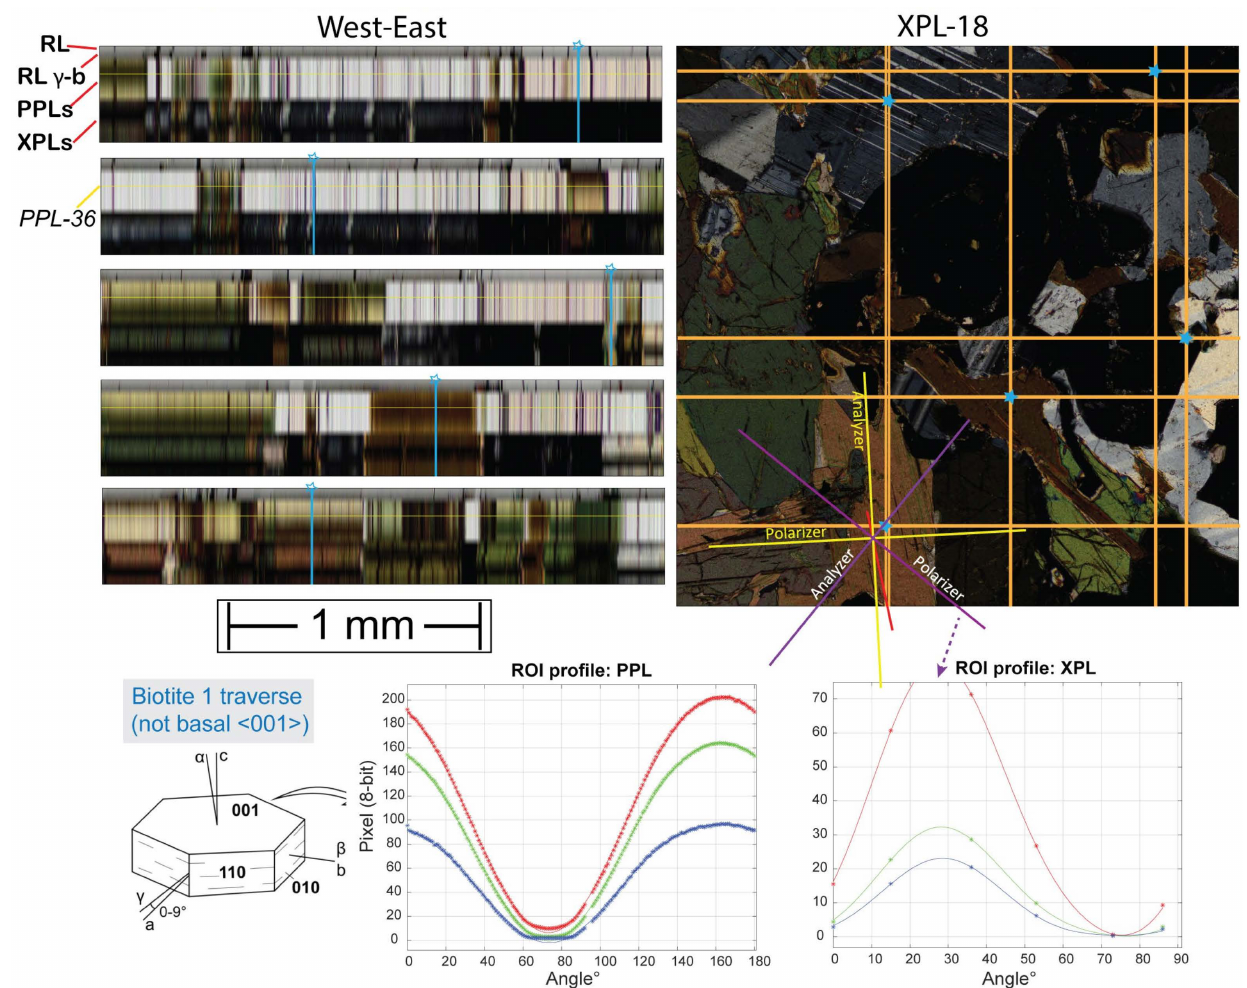
Figure 10. Orthogonal views of Figure 9 stack (pyramidal level = 0) of the hornblende granulite KB-67. The PPL-36 ( top-left ) and XPL-18 ( middle-right ) positions illustrate the mineralogy. Five pixels of distinct mineralogy (biotite 1 and 2, plagioclase, garnet, and chlorite) are marked (blue stars) for each modality (RL, PPL, XPL) and orientation. Colour gradients within the orthogonal traverses are arranged left–right (vertical) and top–bottom (horizontal). The change in PPL and XPL colour is seen as a gradient as the stage is virtually rotated. ROI RGB spectra at 180 (PPL) steps and six steps (XPL) are shown at the bottom with ideal spectral fits to 180 (PPL) and 90 ◦ (XPL) periods.